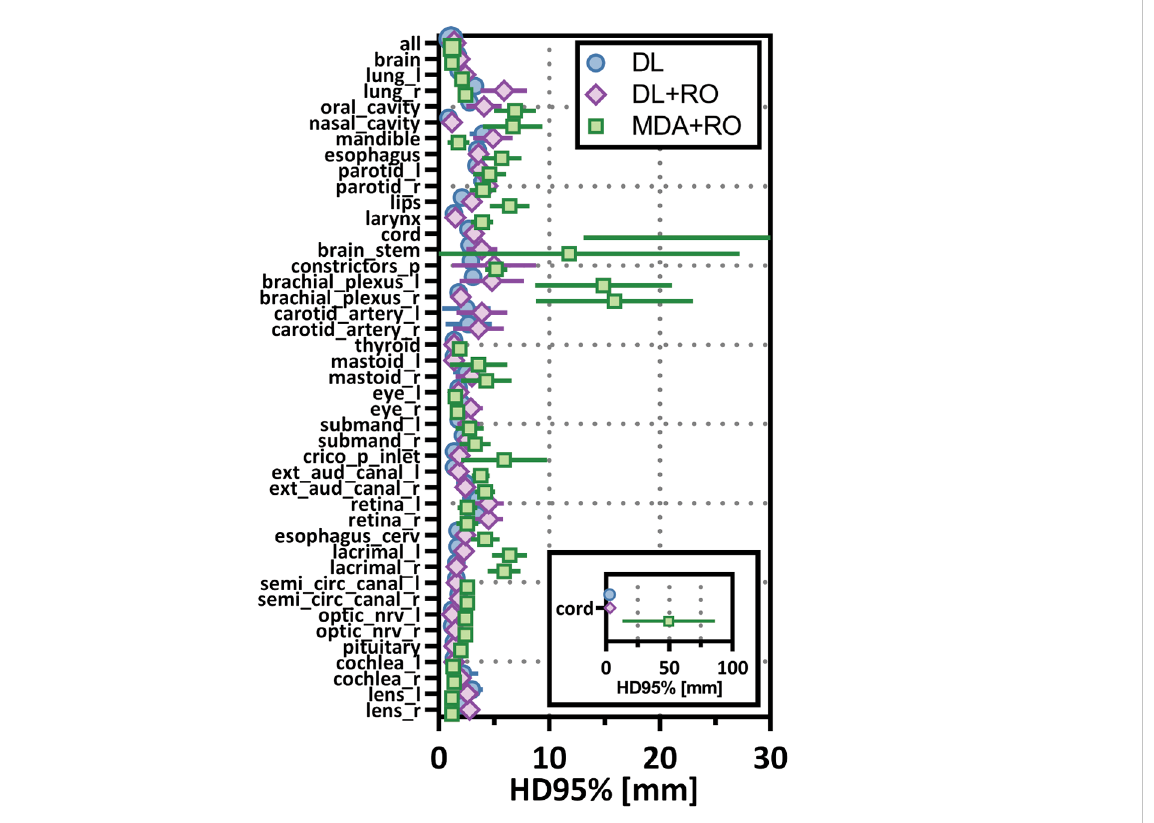
FIGURE 6 Mean 95%-percentile Hausdorff distance (HD95%) with a 1mm tolerance, and 95% con fi dence intervals for the unrevised deep learning (DL), radiation oncologist (RO) revised deep learning (DL+RO), and RO-revisions to the initial MDA contours (MDA+RO), categorized by organ-at-risk type and for all OARs. OARs listed in order of decreasing